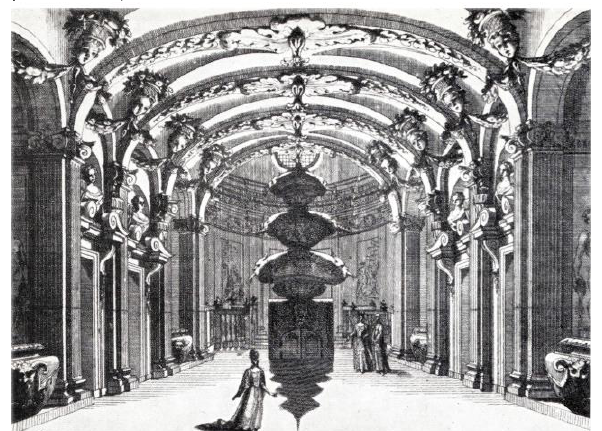
Figure 5 – Marcantonio Chiarini. Galleria delle Palme,